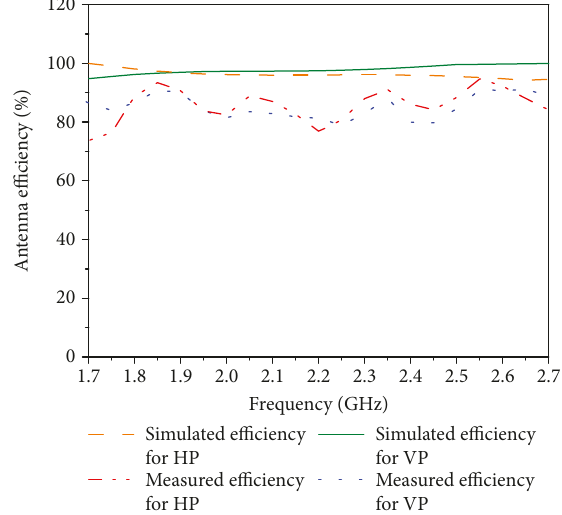
Figure 14: Gain of the wideband DP quasi-omnidirectional antenna.